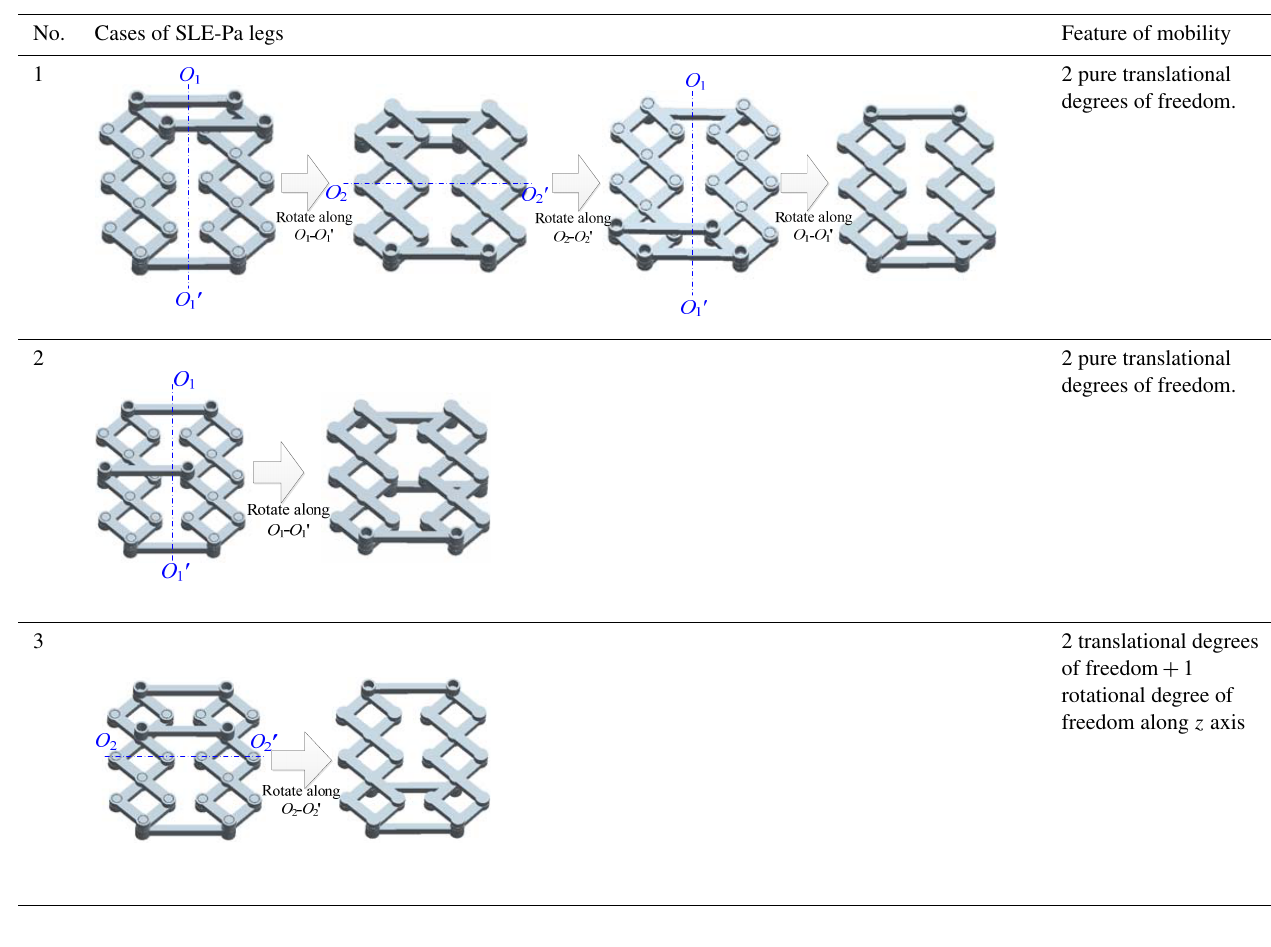
Table 1. Mobility of SLE-Pa legs